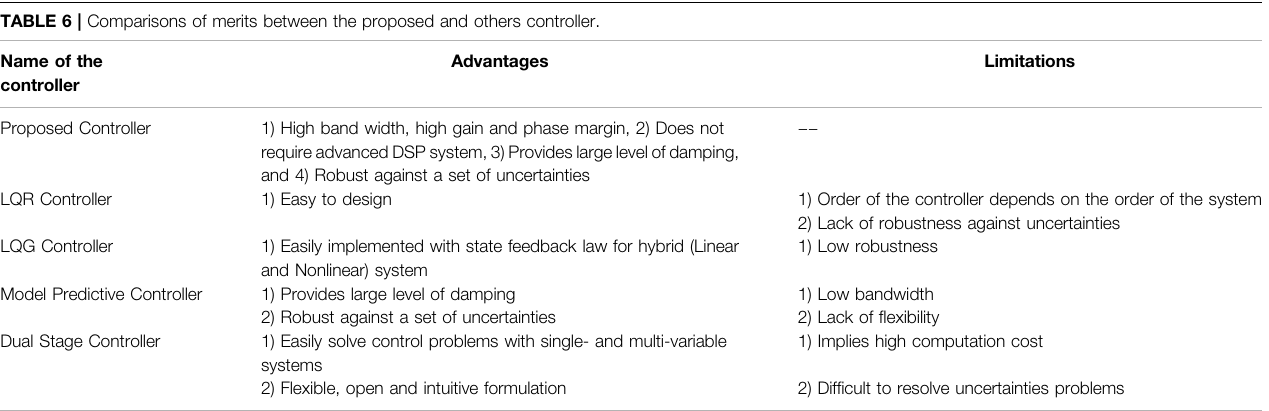
TABLE 6 | Comparisons of merits between the proposed and others controller. Name of the controller